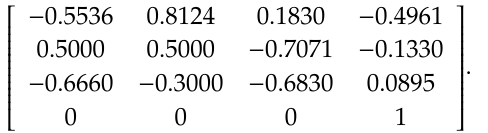
Figure 9. ( a ) Robot in its initial position from the front. ( b ) Robot in its initial position from the side. At that time, based on the forward kinematics computation, the end posture was: